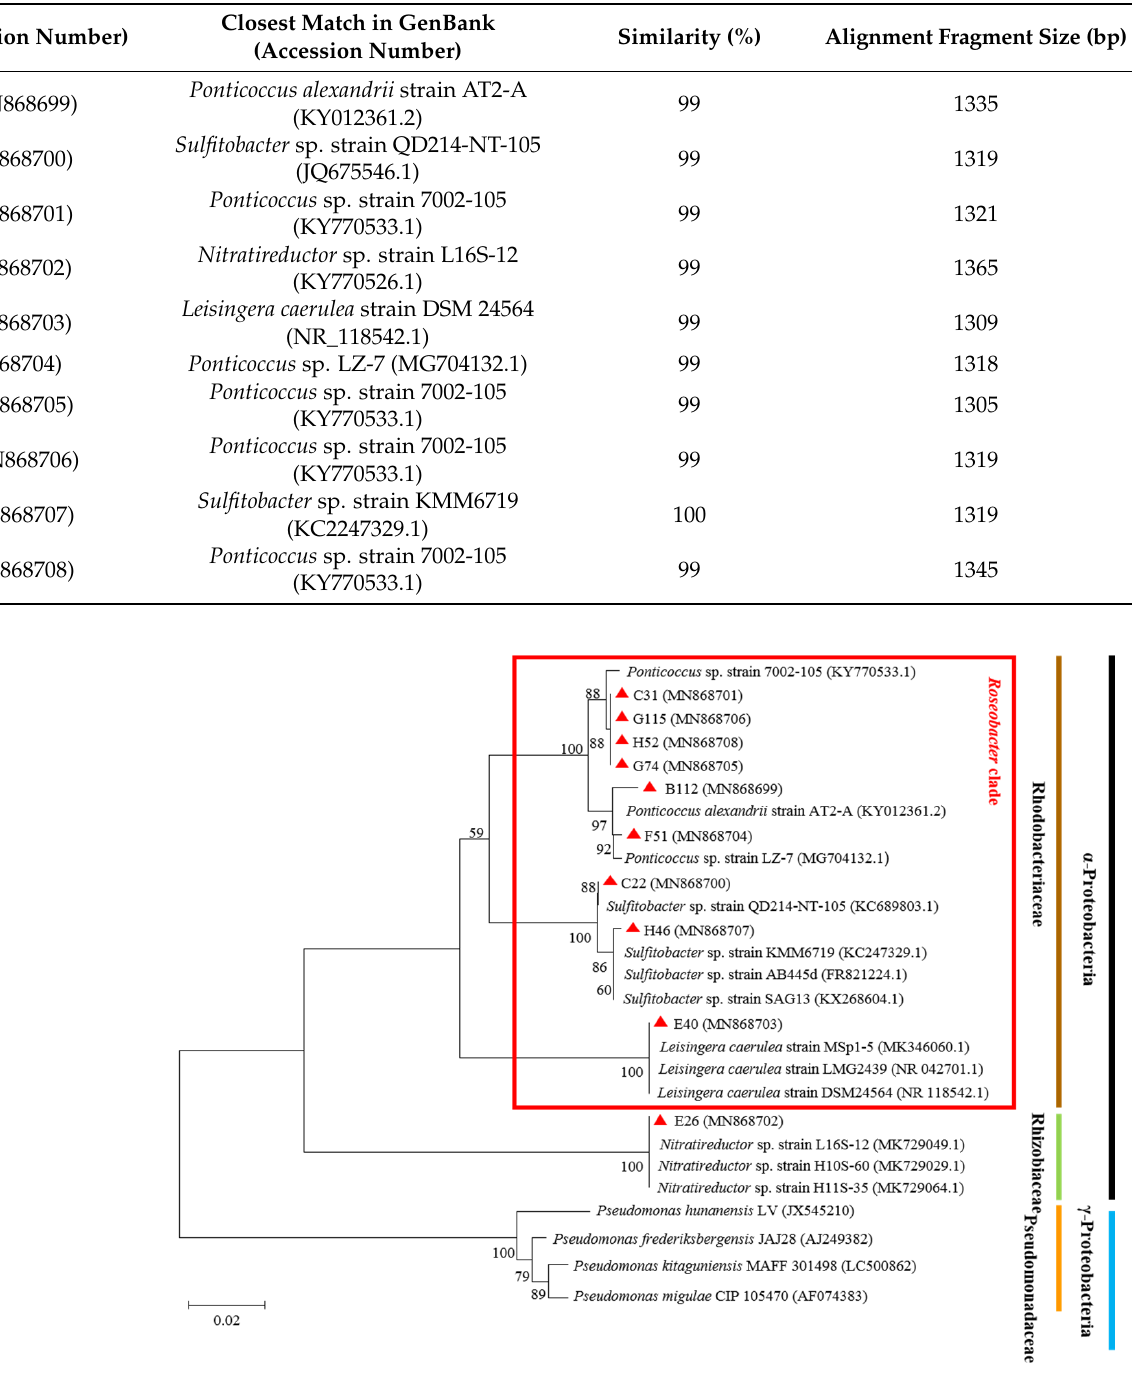
Figure 1. Phylogenetic tree of the QS bacteria isolated from marine HAB species. The black line represents the α -Proteobacteria; the blue line represents the γ -Proteobacteria; the brown line represents Rhodobacteriaceae; the green line represents Rhizobiaceae; the orange line represents Pseudomonadaceae; the red box represents the QS bacteria belonging to the Roseobacter clade; the 10 QS strains are indicated by red triangles.